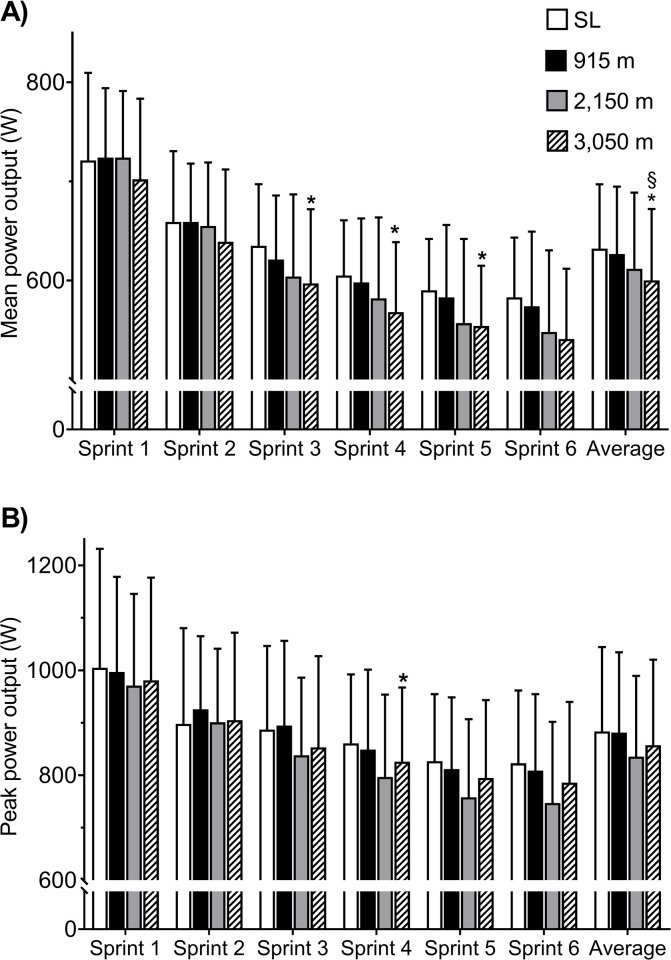
(A) Illustration of the mean power output (MPO) and (B) peak power output (PPO) in watt (W) of each consecutive sprint and average of all six sprints at each altitude. SL: sea-level. * Different from sea-level (P<0.05), § different from 1,000 m (P<0.05).